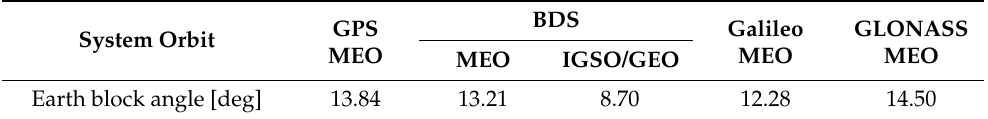
Table 6. Earth block angles of different system